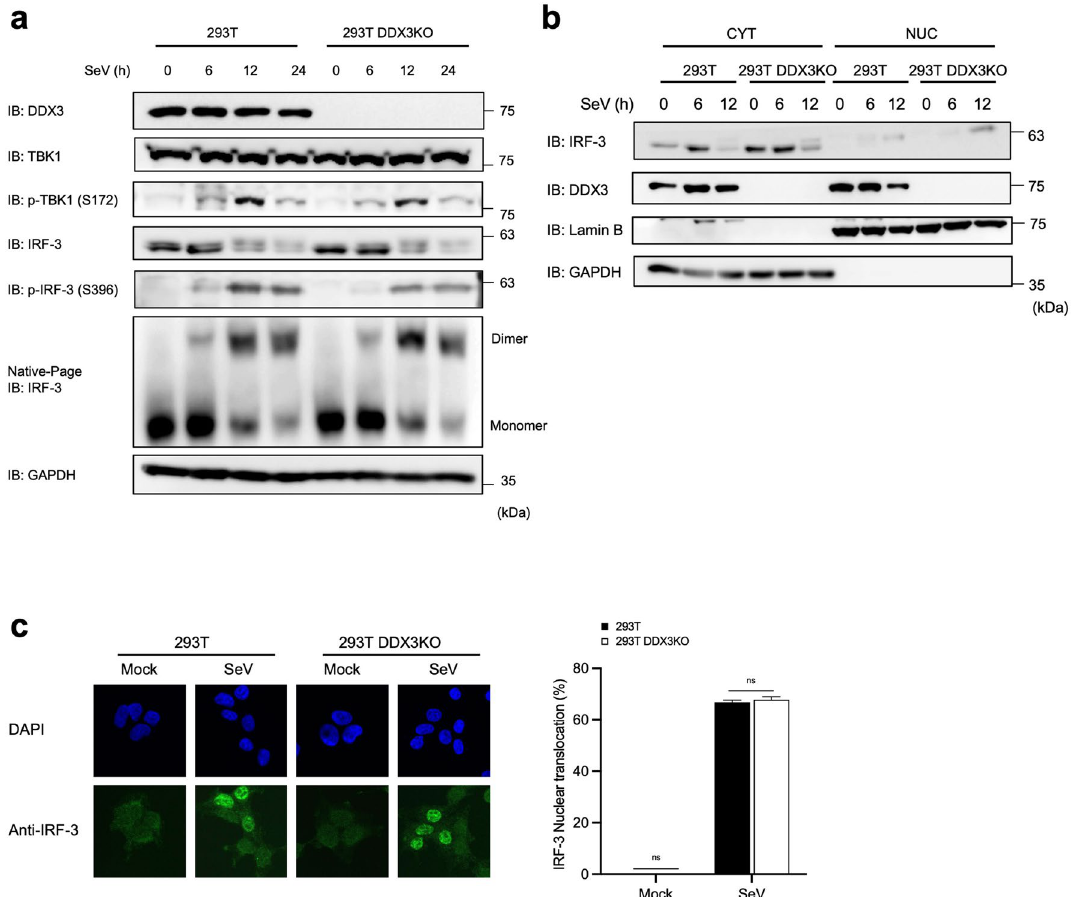
Figure 3. Analysis of different signaling events induced by SeV infection in 293T and 293T DDX3KO cells. ( a ) 293T and 293T DDX3KO cells were mock treated or infected with SeV for the indicated time. Total cell lysates were subjected to SDS-PAGE or native PAGE, followed by immunoblotting using the indicated antibodies. Full- length gels in Supplementary Information. ( b ) 293T and 293T DDX3KO cells were mock treated or infected with SeV for 12 h, and then subjected to subcellular fractionation. Cytoplasmic and nuclear extracts were examined by immunoblotting using the indicated antibodies. Full-length gels in Supplementary Information. ( c ) 293T and 293T DDX3KO cells were mock treated or infected with SeV for 12 h. Cells were fixed and stained for endogenous IRF-3 (green) and nuclear DNA was stained with DAPI (blue). Cells were observed by